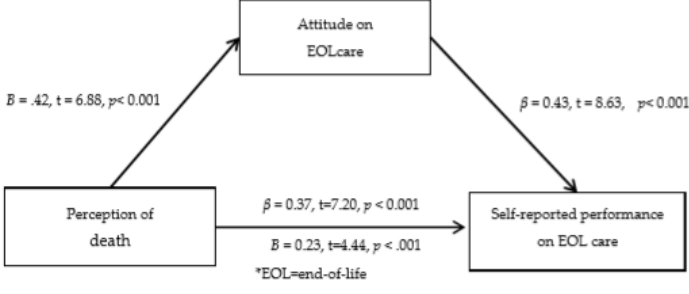
Figure 1. Mediating Role of Attitude on EOL Care on The Relationships Between Perception of Death and Self-reported Performance on EOL